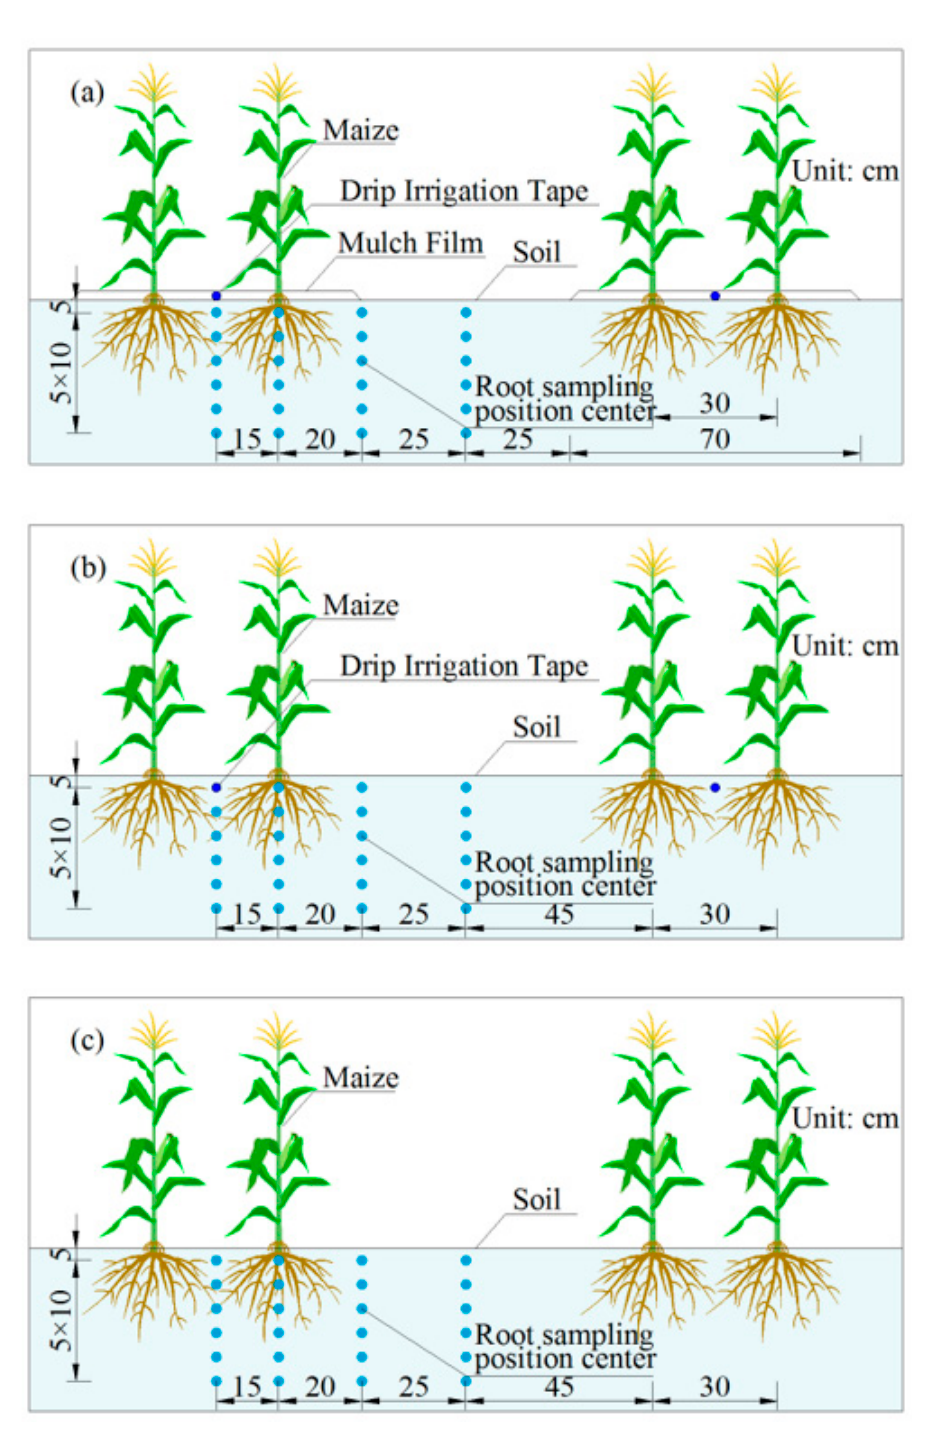
Figure 2. Schematic of Maize Planting and Irrigation. ( a ) Mulched drip irrigation; ( b ) shallow-buried drip irrigation; ( c ) sprinkler irrigation.